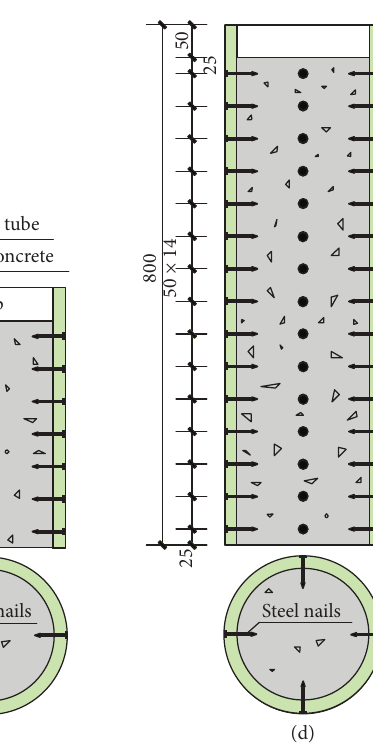
Figure 3: Number and positions of shear connectors of specimens with different lengths. (a) 100mm. (b) 200mm. (c) 400mm. (d) Table 3: Properties of concrete. Concrete stress